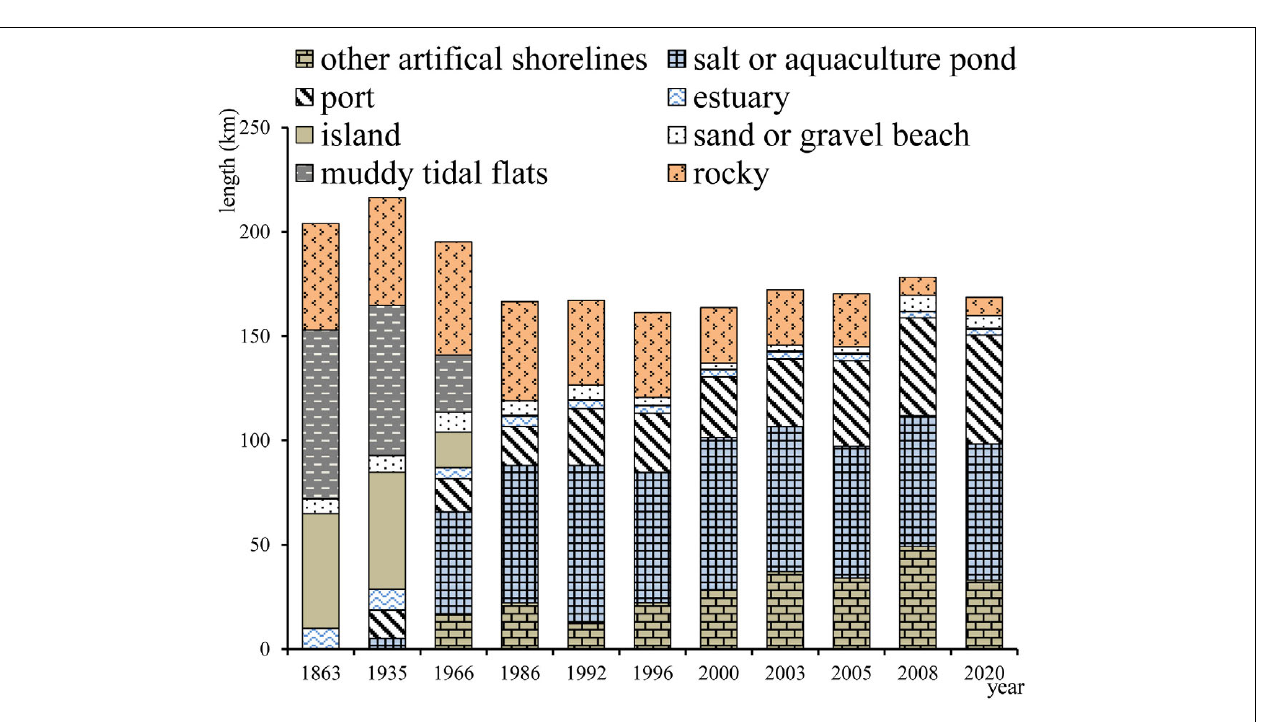
FIGURE 5 | Length of each coastline type in Jiaozhou Bay over 150